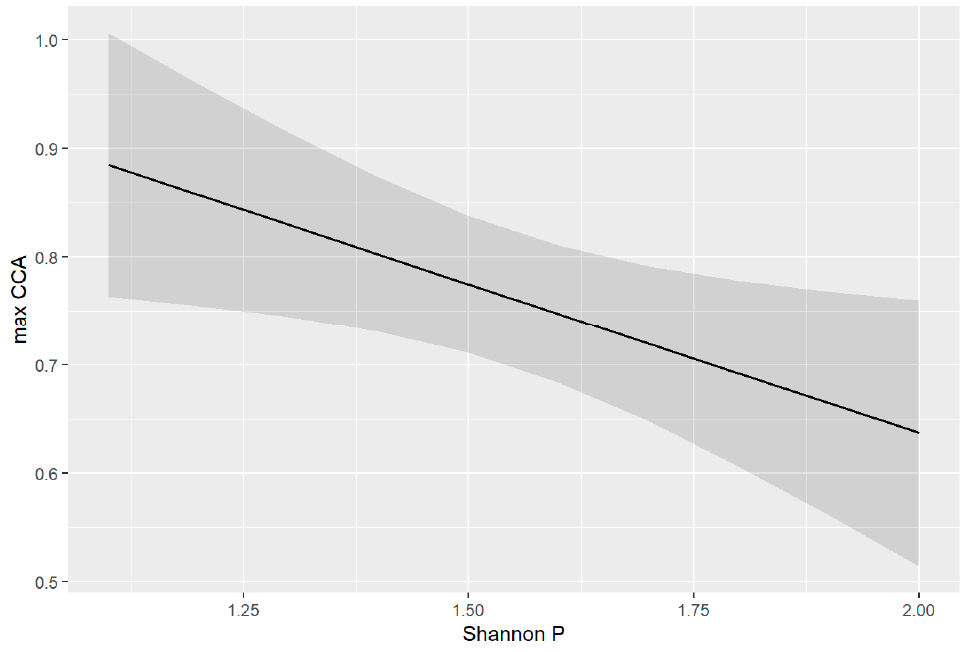
Figure 8. The correlation between Shannon index at the phylum taxonomic level and maximal CCA IMT. The results of PCAs are shown in Figures